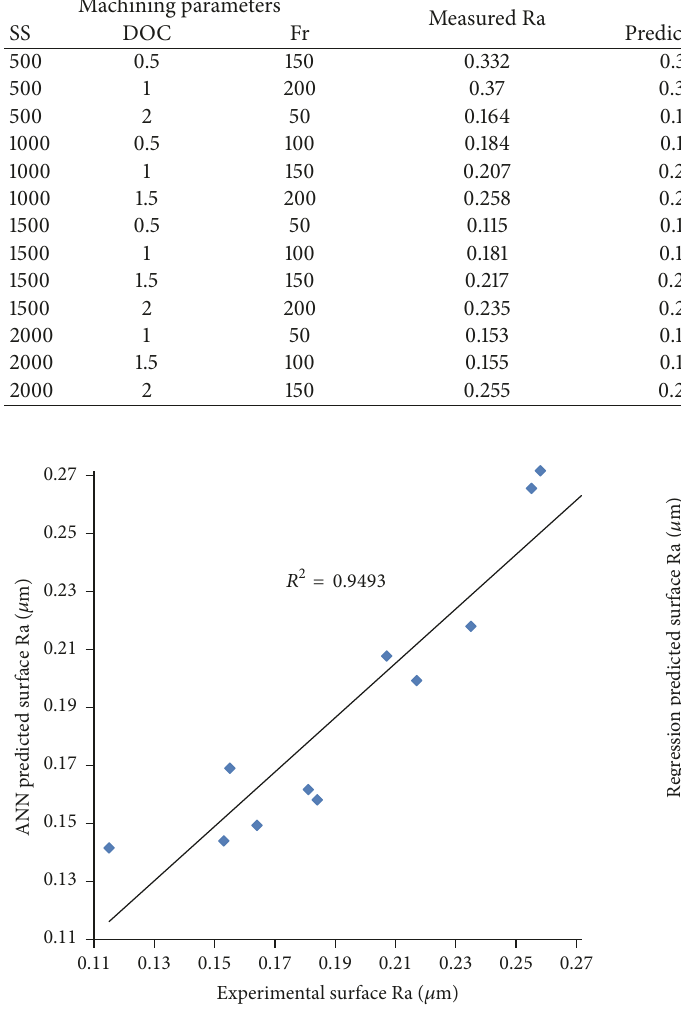
Figure 4: Experimental and ANN predicted results in the test period.